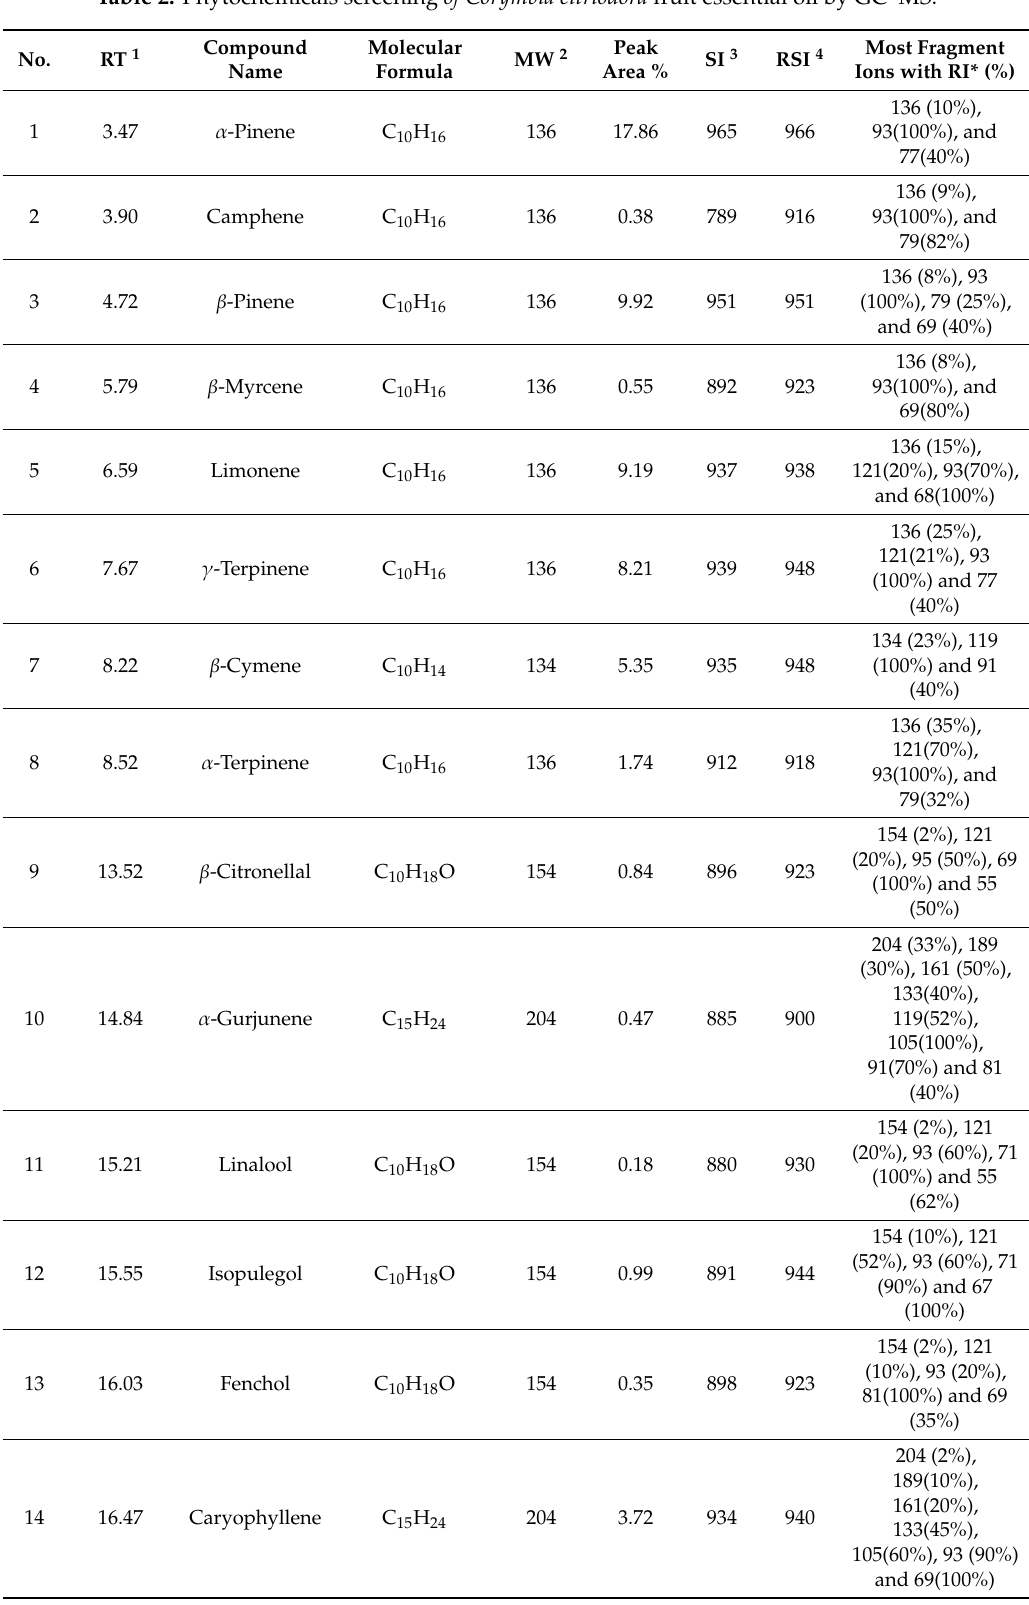
Table 2. Phytochemicals screening of Corymbia citriodora fruit essential oil by GC–MS.